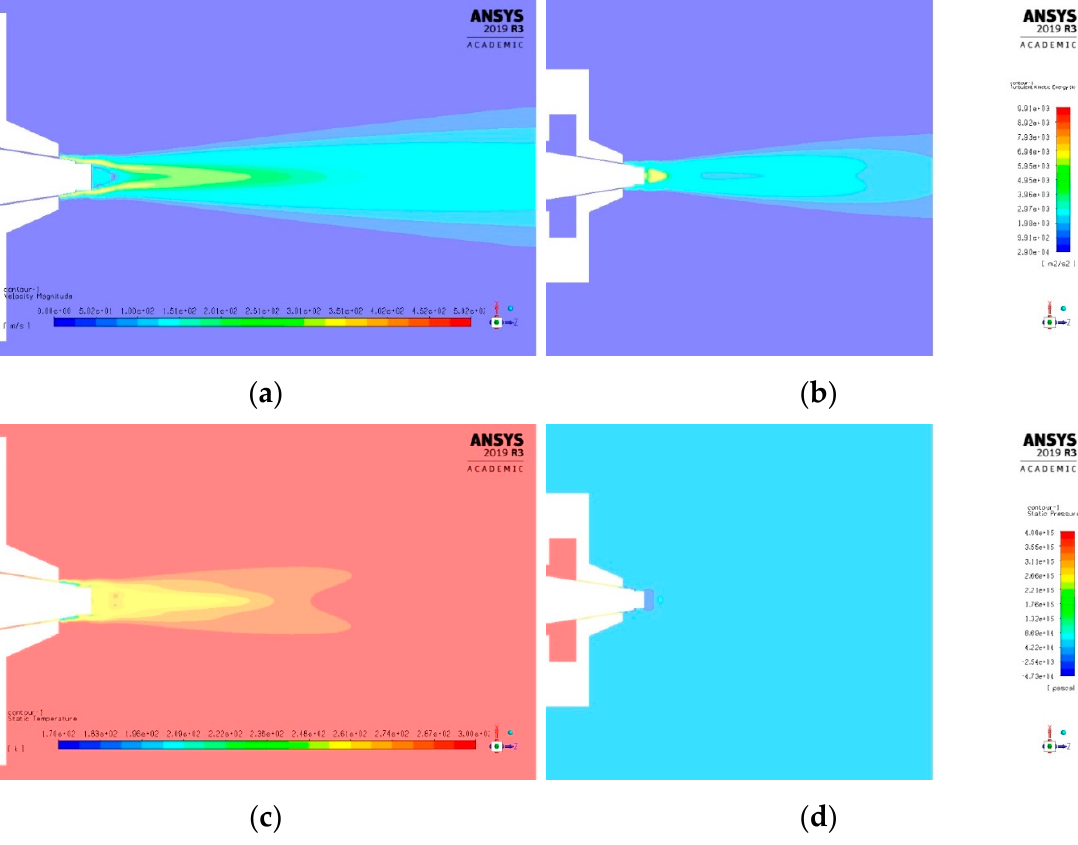
Figure 8. k- ε turbulence flow contours through SBS nozzle at air pressure of 4 bar: ( a ) velocity (m/s), ( b ) turbulent kinetic energy (J/kg = m 2 /s 2 ), ( c ) temperature (K), and ( d ) pressure (Pa).